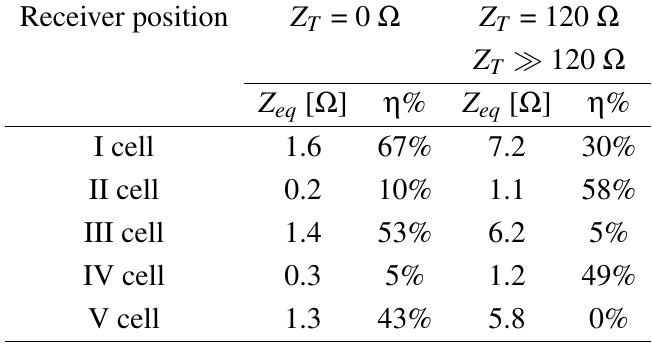
Table 1. Equivalent impedance values, Z positions and conditions calculated with Equation